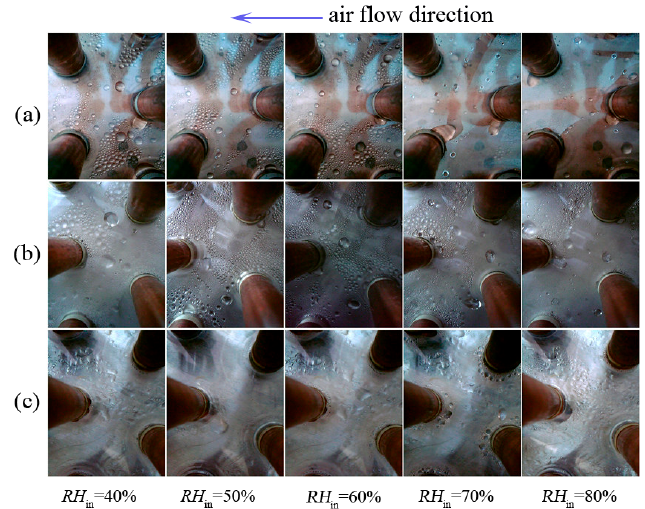
Figure 8. Effect of RH in on geometry form of condensate water on the fin surfaces of three different materials: ( a ) copper fin, ( b ) aluminum fin, ( c ) aluminum fin with a hydrophilic layer.